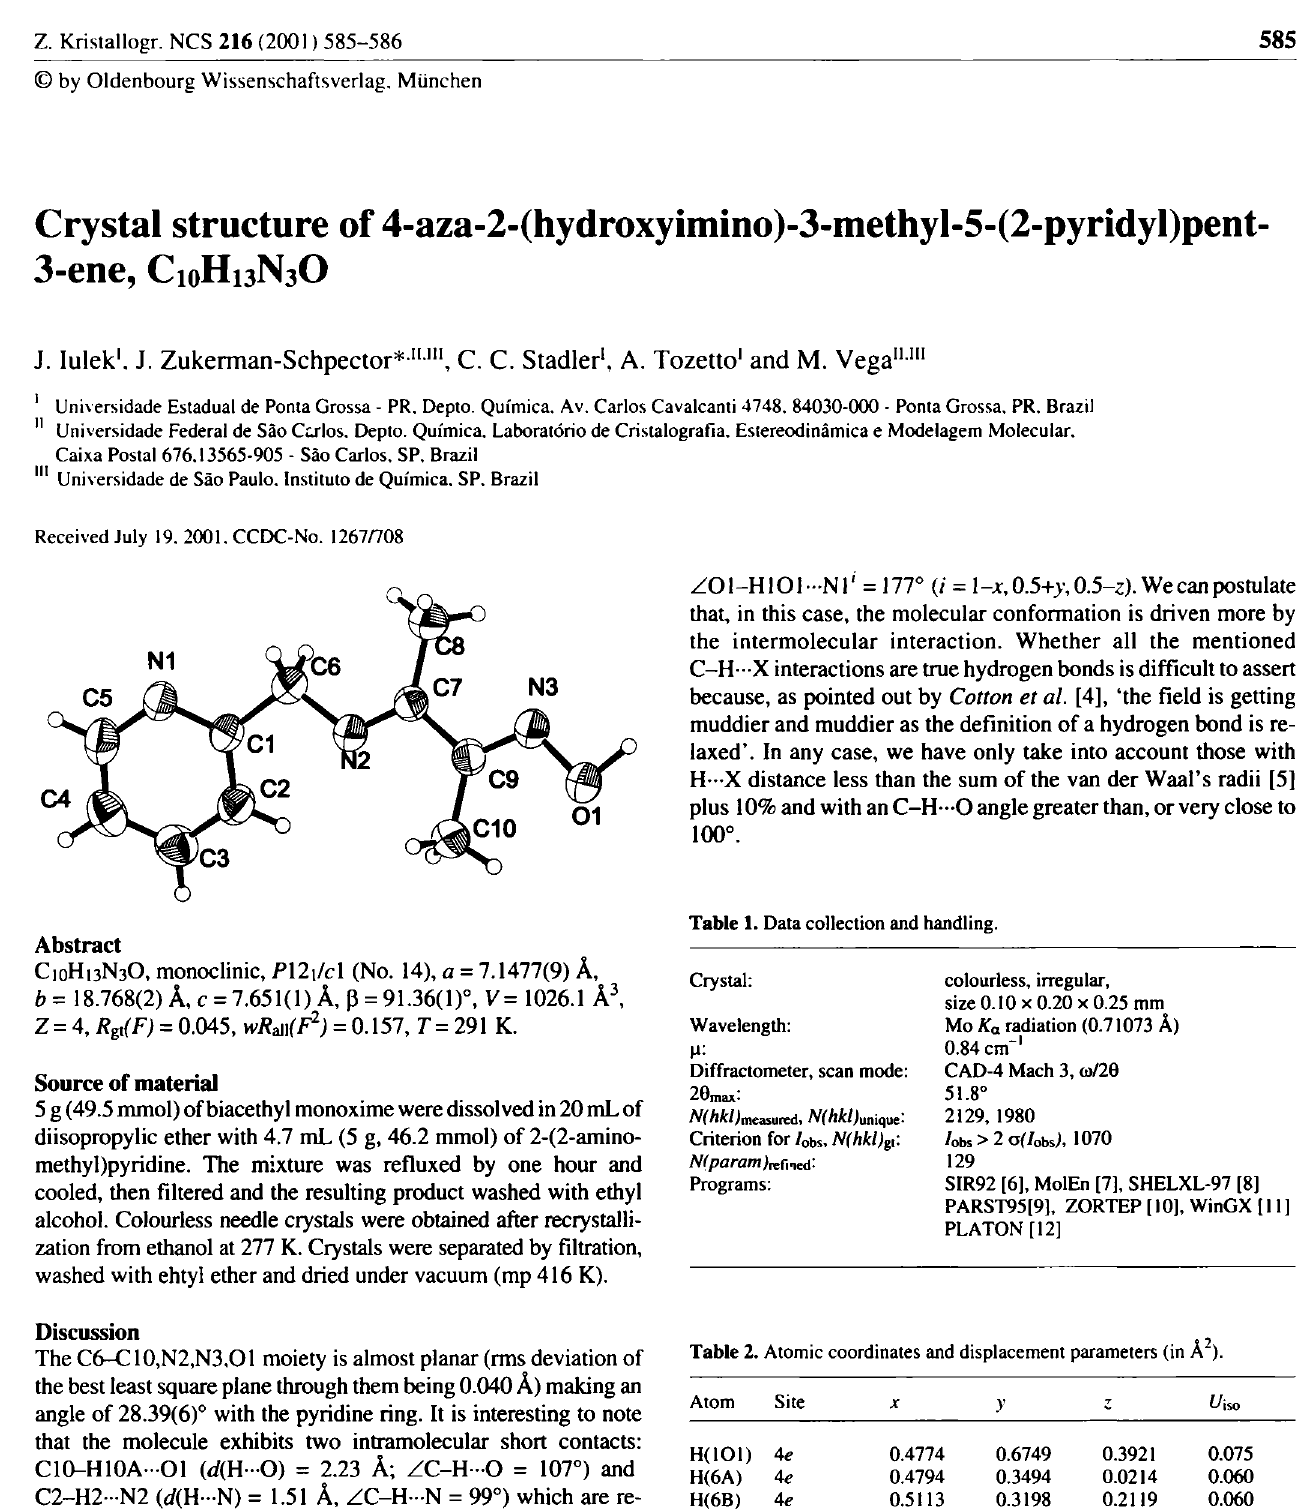
Table 2. Atomic coordinates and displacement parameters (in A 2